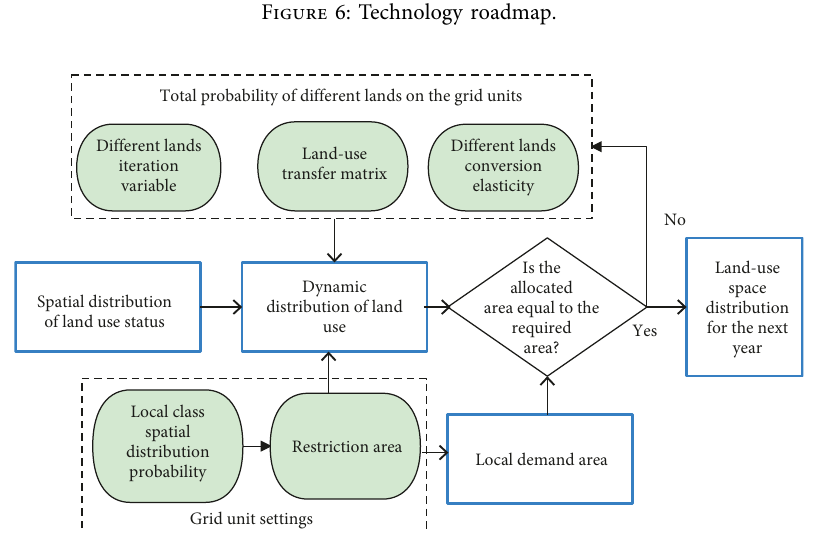
Figure 6: Technology roadmap.